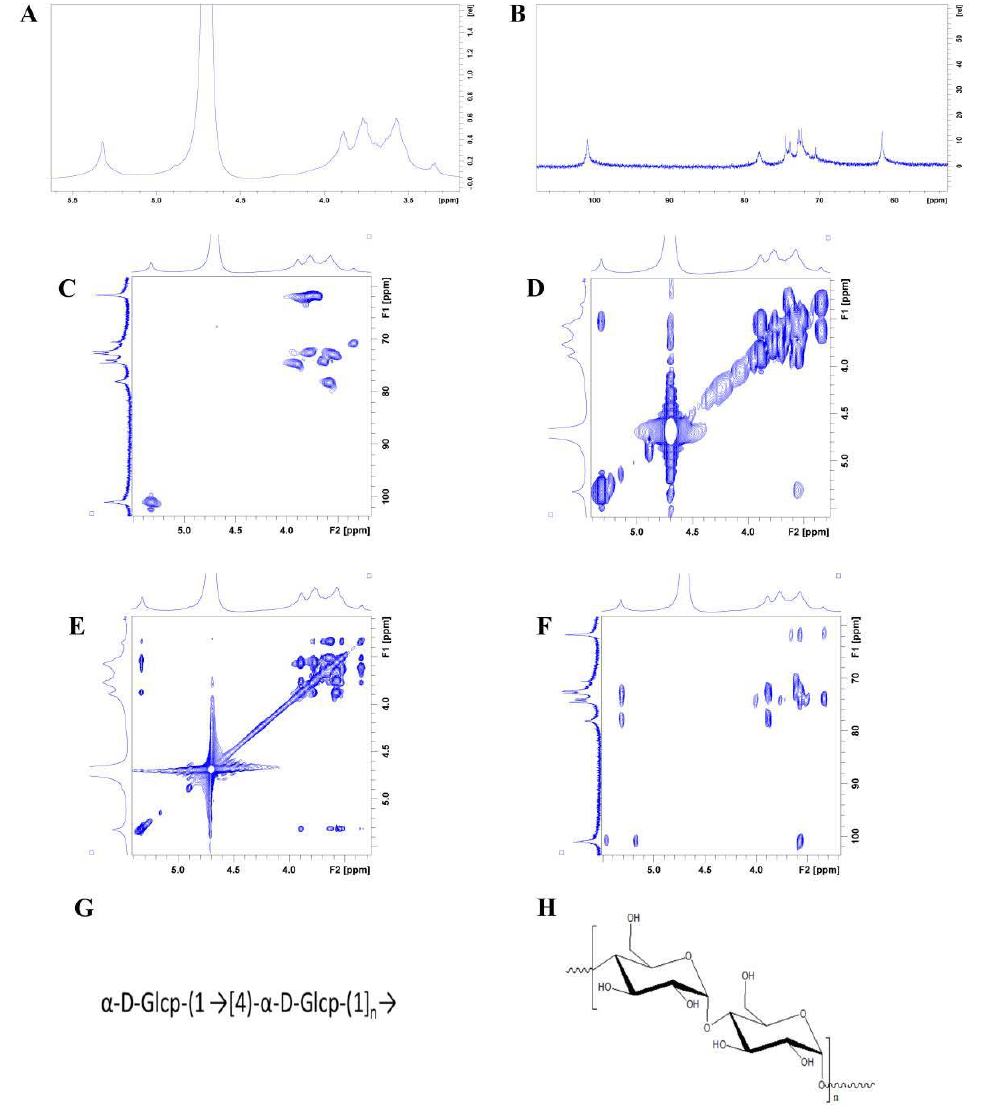
Figure 5. NMR spectrum and structure of PAP-1. ( A ) 1 H NMR spectrum; ( B ) 13 C NMR spectrum; ( C ) HH-COSY spectrum; ( D ) HSQC spectrum; ( E ) HMBC spectrum; ( F ) TOCSY spectrum; ( G ) Bonding structures of PAP-1; ( H ) Structural formula of PAP-1.